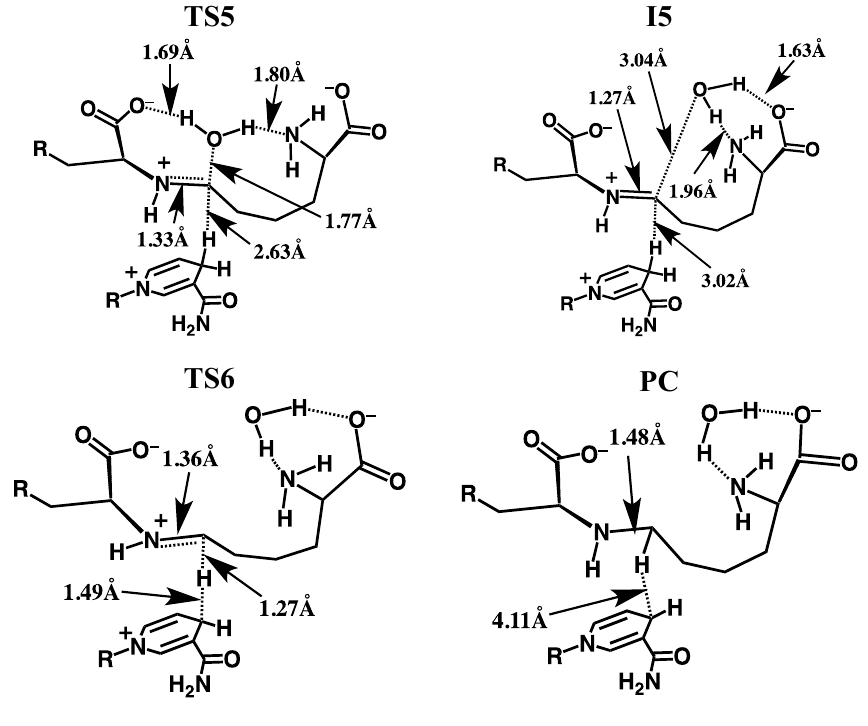
Figure 6. Optimized structures of TS5 , I5 , TS6 and PC obtained at the ONIOM(HF/6- 31G(d):AMBER94)-ME level of theory with selected distances shown (in